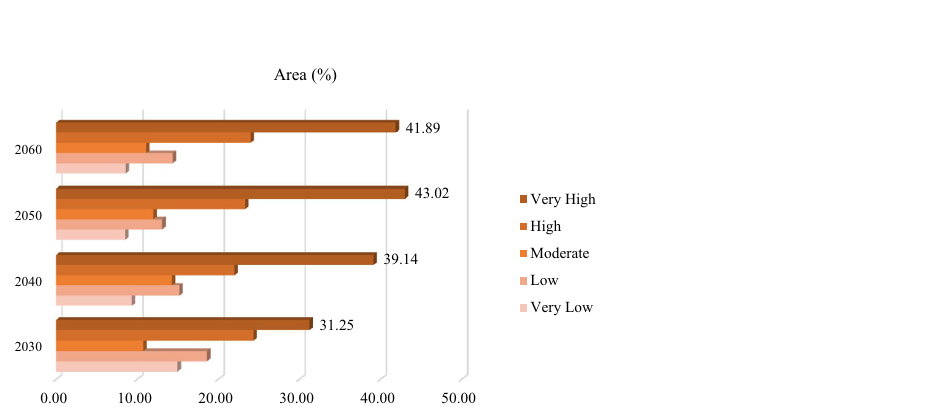
Figure 12. Results of the frost-affected areas predication using the CA–Markov model for the years 2030, 2040, 2050, and 2060, generated in the ArcGIS 10.6 software (www. esri. com).